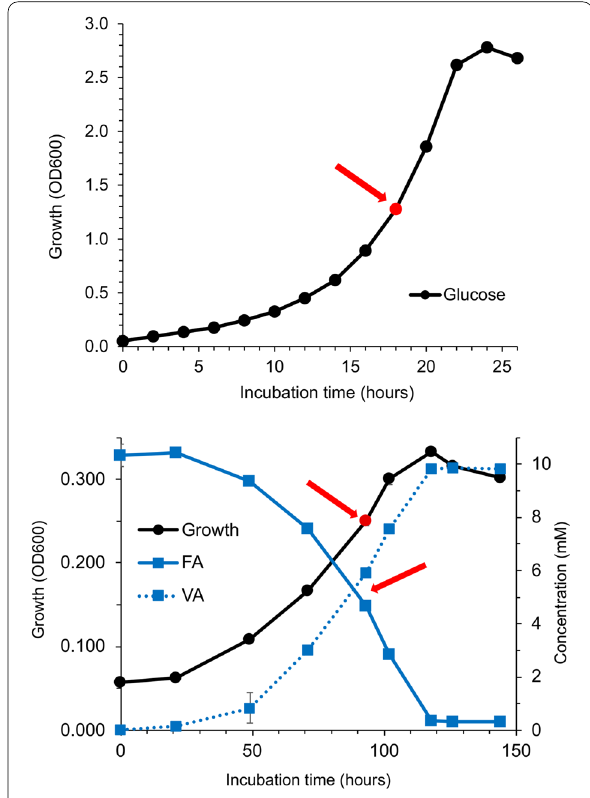
Fig. 1 Growth curves of P. aromaticivorans AR20-38 based on OD600 values and HPLC values. Upper panel: cultivation with glucose as sole carbon source; Lower panel: cultivation with ferulic acid as sole carbon source. HPLC results of ferulic acid depletion and vanillic acid production are marked in blue. Red points and arrows mark the timepoints of biomass harvesting. Values plotted are the mean of triplicates from independent cultures, standard ±